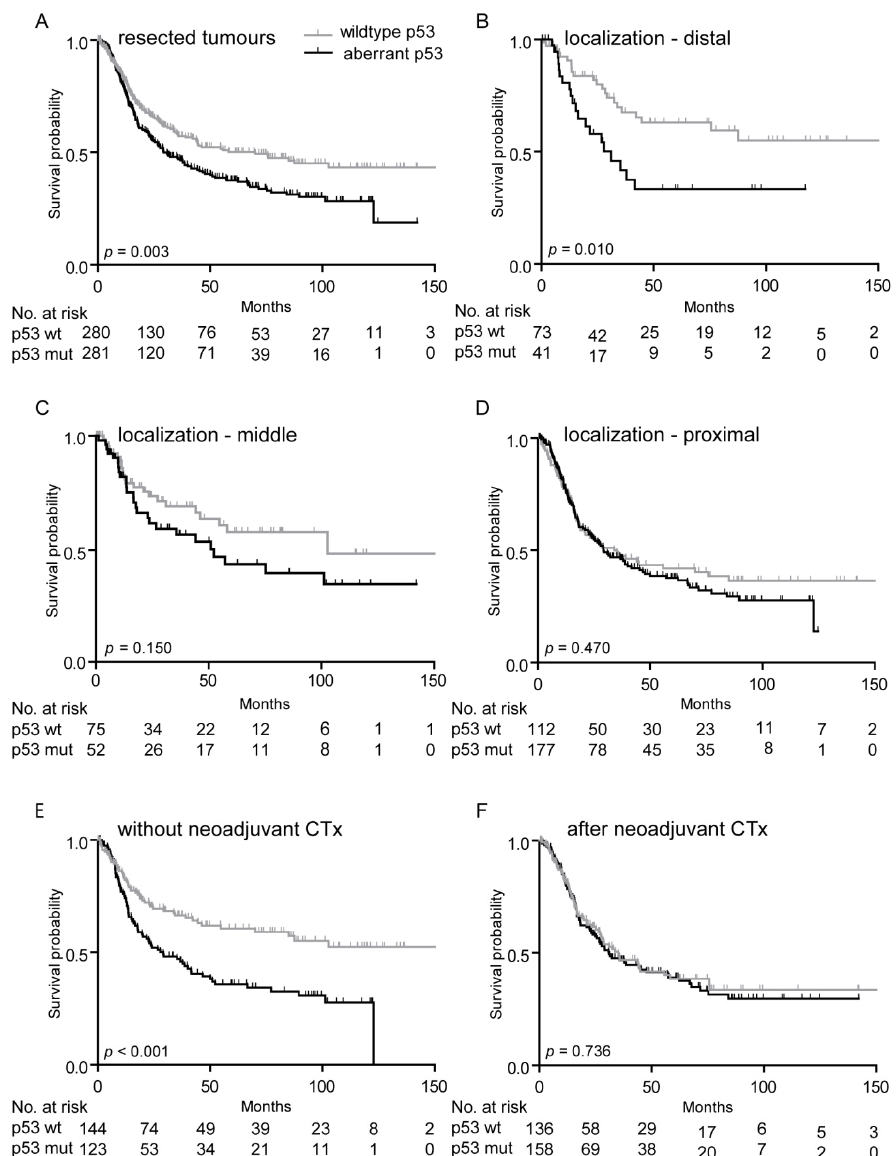
Figure 2. Survival of patients with resection specimens in association with p53 expression. Kaplan–Meier curves of the patients with wild-type and aberrant p53 are shown. All resection specimens ( A ); resection specimens with distal ( B ), middle ( C ), and proximal ( D ) tumor localization; resection specimens without CTx ( E ) and after neoadjuvant CTx ( F ). p53 wt, p53 wild-type expression; p53 mut, aberrant p53 expression; No., number; p -value of log-rank test (overall).